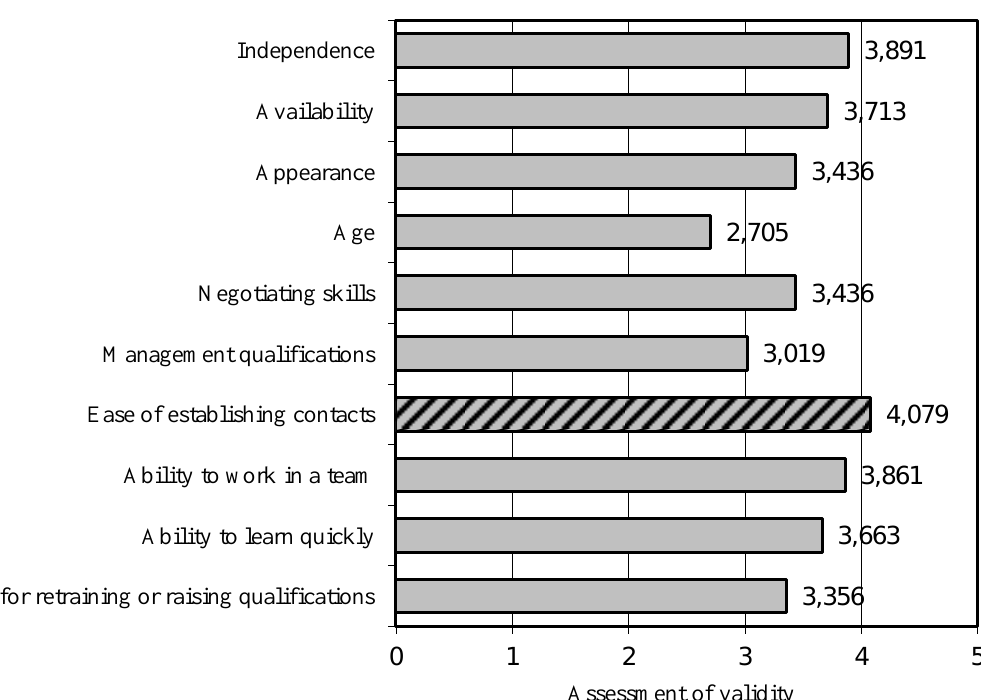
Fig. 2. The assessment of validity of soft competences when hiring employees in companies in Słupsk local labour market in